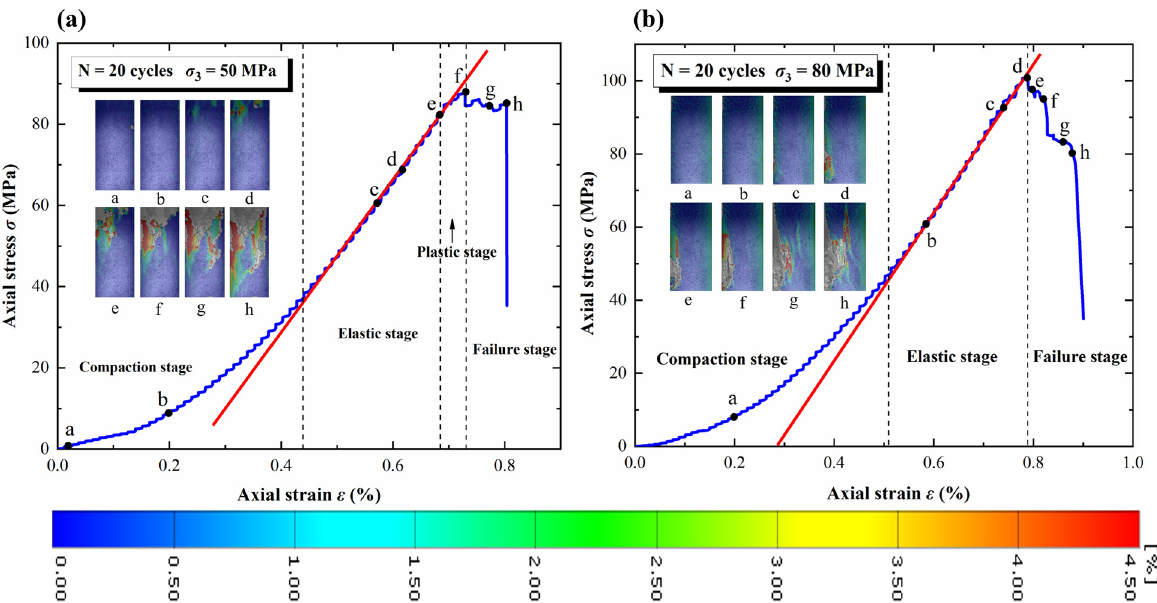
Figure 10. Crack evolution process of pre-damaged specimen after 20 cycles. ( a ) σ 3 = 50 MPa; ( b ) σ 3 = 80 MPa.